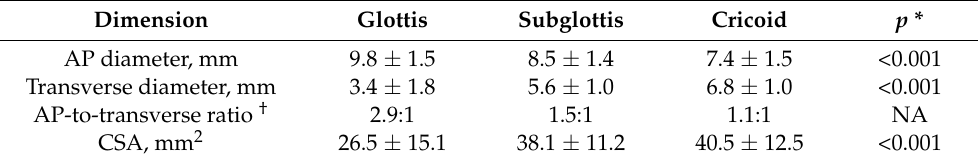
Table 1. Laryngeal dimensions per level (n = 401).